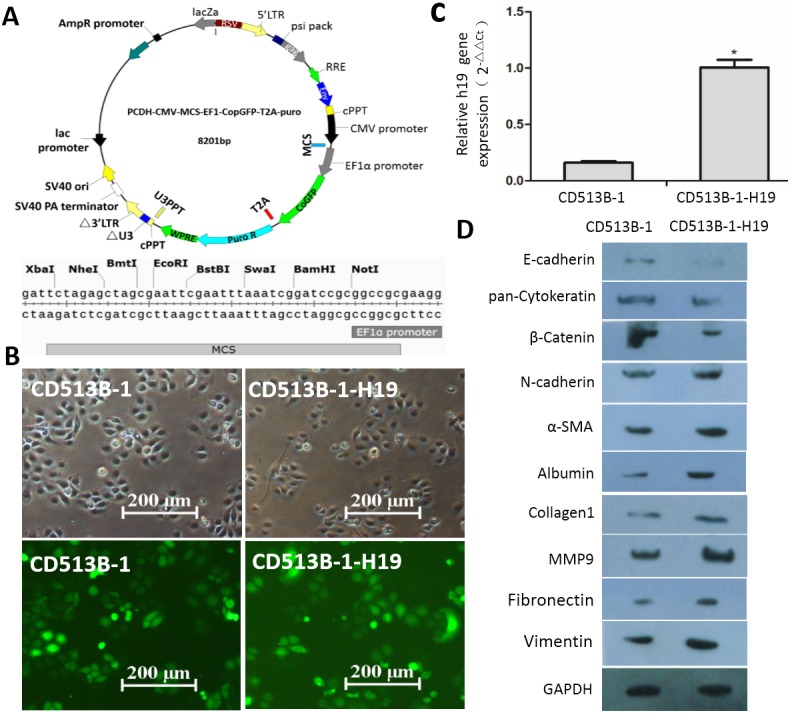
H19 promotes EMT progression and ECM protein expression induced by TGF-β1 in MAC-T cells.(A) Information for the lentviral vector CD513B-1. BamHI and NotI sites in CD513B-1 were used to construct the expression plasmid. (B) Fluorescence microscopy examination of MAC-T cells transfected with lentviral vectors. GFP expression was observed by fluorescence microscopy. Up, MAC-T cells infected with CD513B-1 or CD513B-1-H19 were detected in bright field; down, MAC-T cells infected with CD513B-1 or CD513B-1-H19 were detected in dark field. (C) Analysis of H19 expression in MAC-T cells with empty vector or CD513B-1-H19 by RT-qPCR. (D) The expression of EMT marker proteins (E-cadherin, N-cadherin, pan-cytokeratin, β-catenin, vimentin and α-SMA) and ECM proteins (albumin, collagen 1, fibronectin and MMP9) were evaluated in H19-overexpressing MAC-T cells by western blotting. Control vector-transduced cells were used as a control. GAPDH was used as an internal control. ∗p < 0.05 vs control.